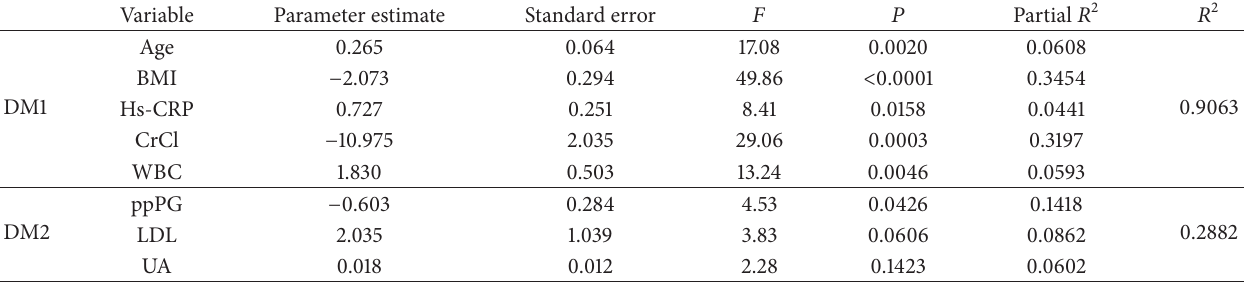
Table 4: Results of stepwise regression analysis for ApN as a dependent variable in DM1 and